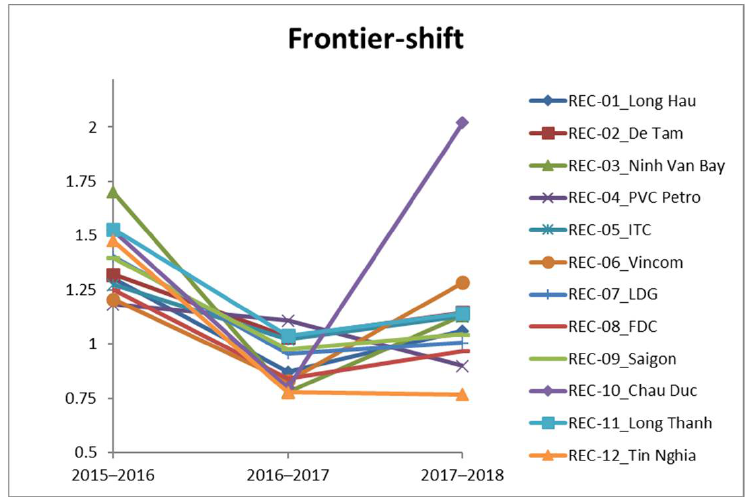
Figure 3. Technological efficiency change (2015–2018).